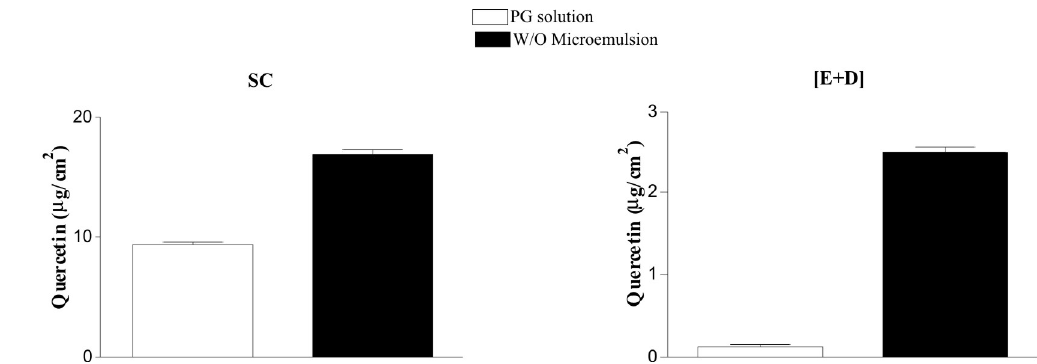
FIGURE 2 - In vitro quercetin penetration in the stratum corneum (SC) and in the epidermis plus dermis ([E+D]) after 12 hours post-application of a propylene glycol (PG) solution and w/o microemulsion, both containing quercetin (0.3%,